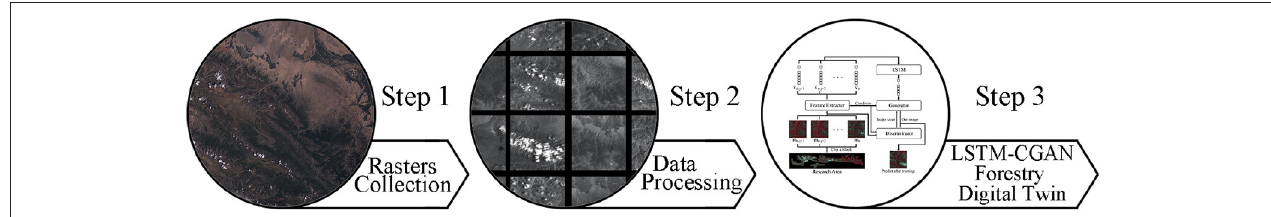
FIGURE 1 | Project work flow.